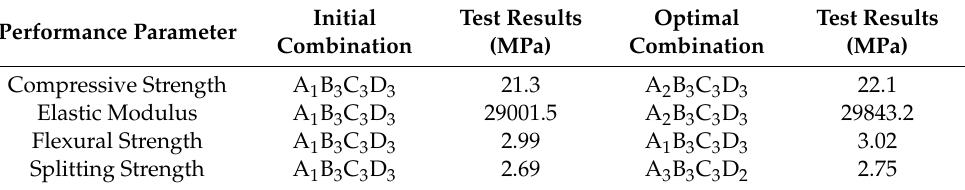
Table 15. Results of the confirmation